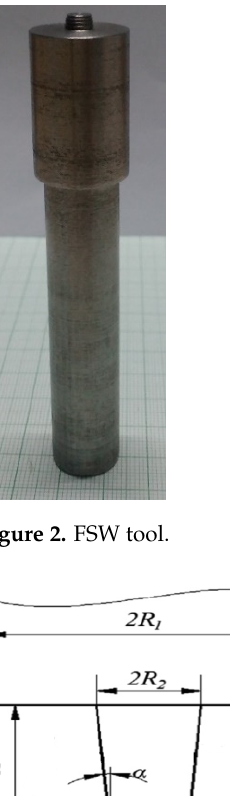
Table 2. Mechanical properties of AA 6061-T6 and Cu B370.